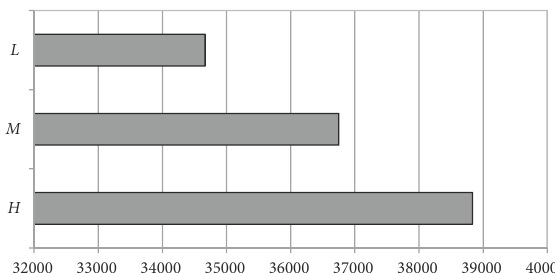
Figure 5. Increased chartering capacity